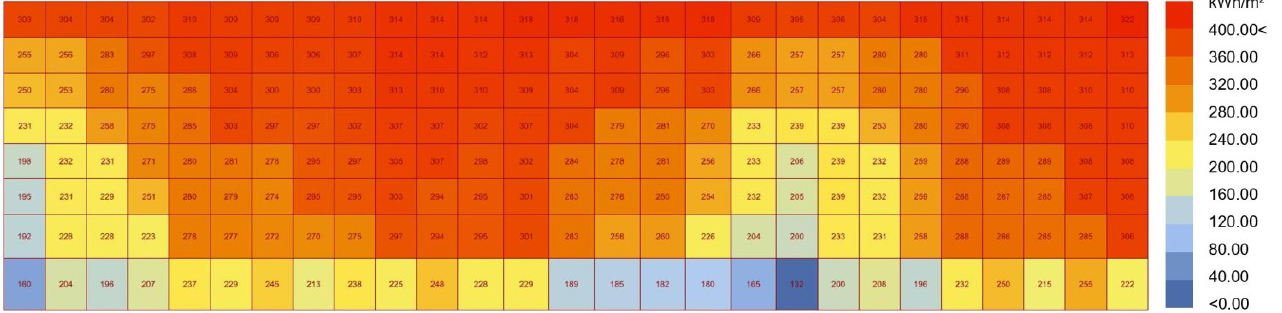
Figure 11. The simulated radiation value on every window unit.